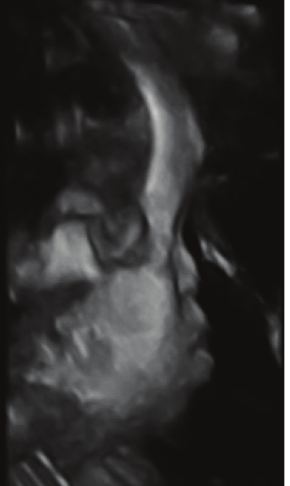
Figure3:3Dultrasoundat21weeksshowsstrikingnasalhypoplasia.